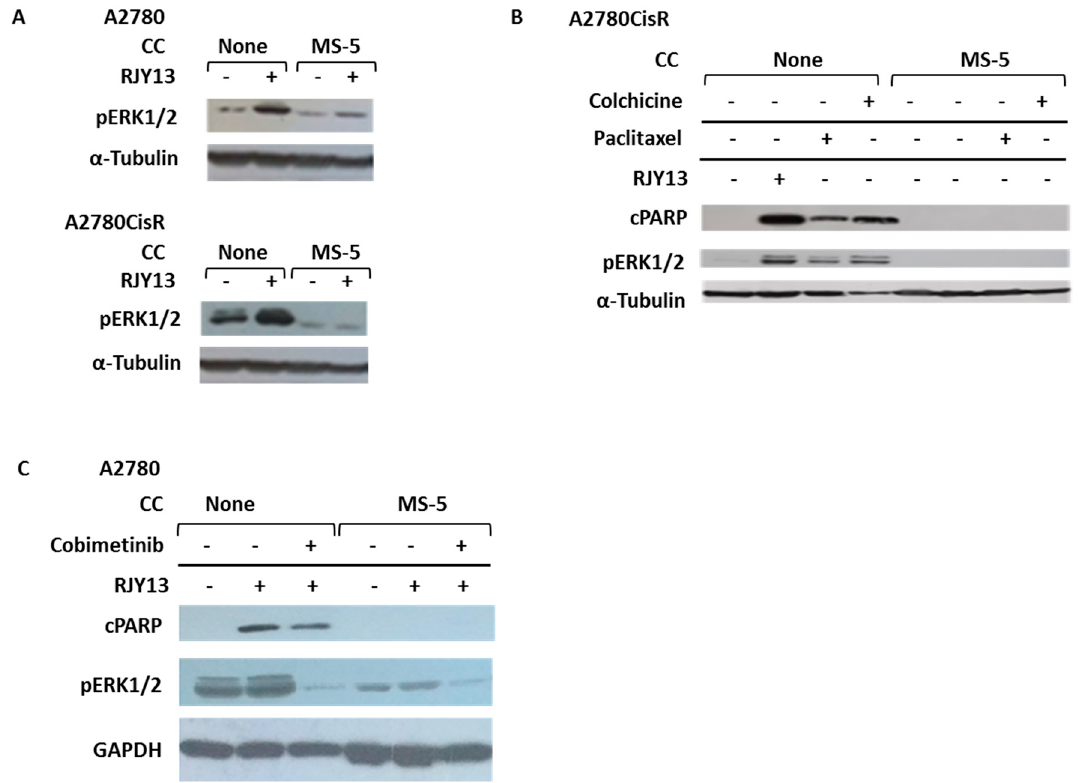
Figure 4. Co-culture of MS-5 cells with OC cells blocks ERK1/2 activation . OC cells sensitive (A2780; A ) and resistant (A2780CisR; A , B ) to cisplatin were treated with 5 μ M RJY13 ( A , B ), 50 nM colchicine, or 25 nM paclitaxel (B) alone or in co-culture with MS-5 cells. Levels of cleaved PARP (cPARP) and phospho-ERK1/2 (pERK1/2) were monitored. A2780 cells were treated with RJY13 (5 μ M) in mono or co-culture with MS-5 cells in the presence or absence of 2 μ M cobimetinib ( C ). α -Tubulin ( A , B ) and GADPH ( C ) were used as loading controls. CC, co-culture.